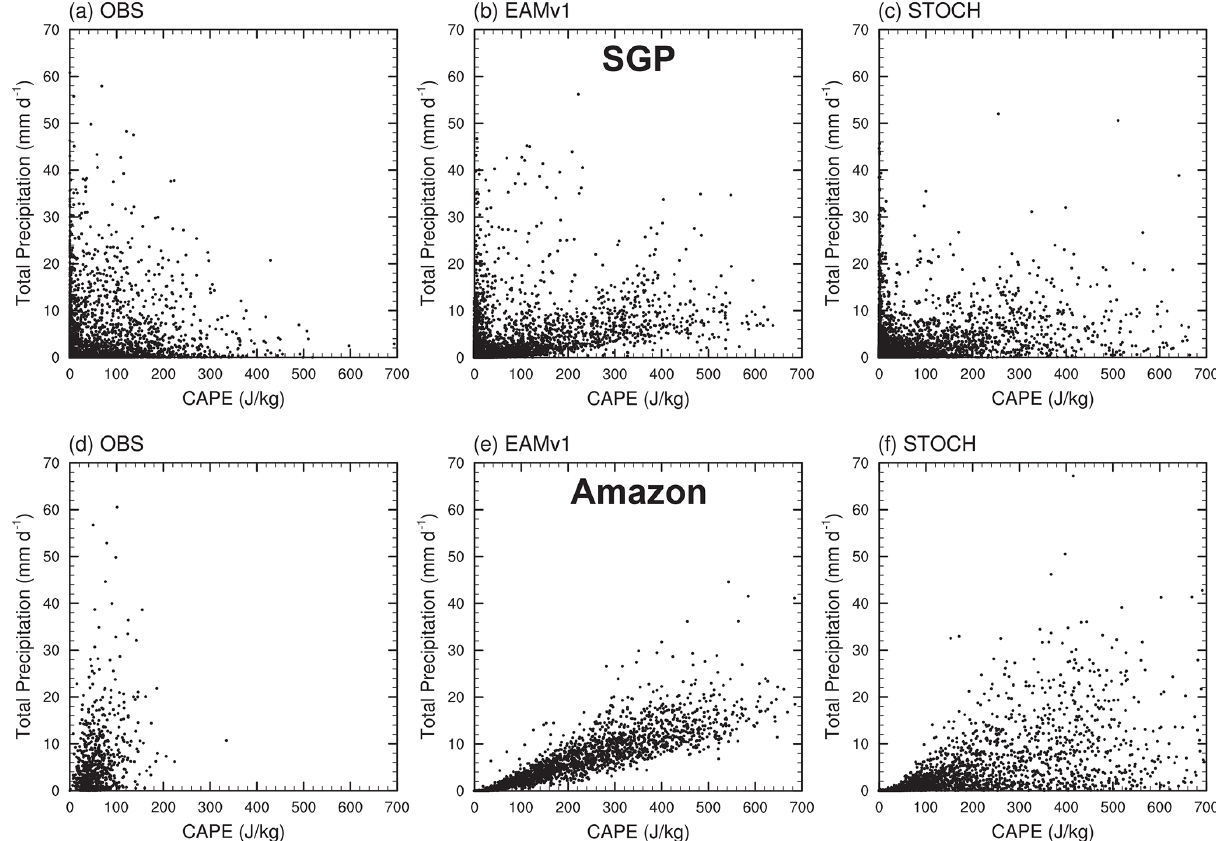
Figure 10. Scatterplots of total precipitation versus CAPE at the ARM (a–c) SGP and (d–f) Amazon sites for (a, d) observations calculated from multiyear sounding data (2014–2015 for the Amazon and 2004–2018 for SGP), (b, e) EAMv1 and (c, f) STOCH.